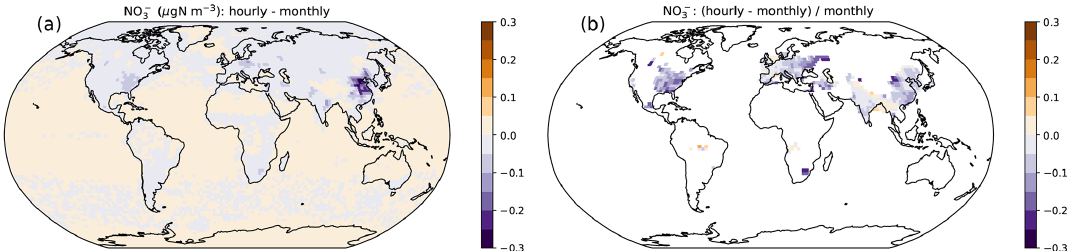
− concentration between the simulations with monthly and hourly NH 3 emissions. 3 concentration in the monthly simulation. The relative 3